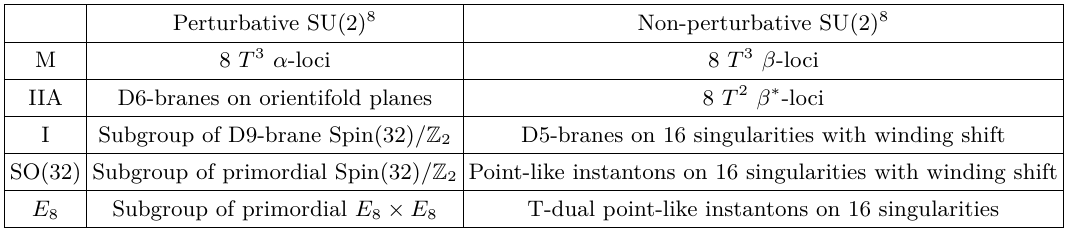
Table 3 . Origin of non-abelian gauge symmetry in the N = 2 model at each stage of the duality chain. “Perturbative” and “Non-perturbative” labels refer to the string coupling of the heterotic